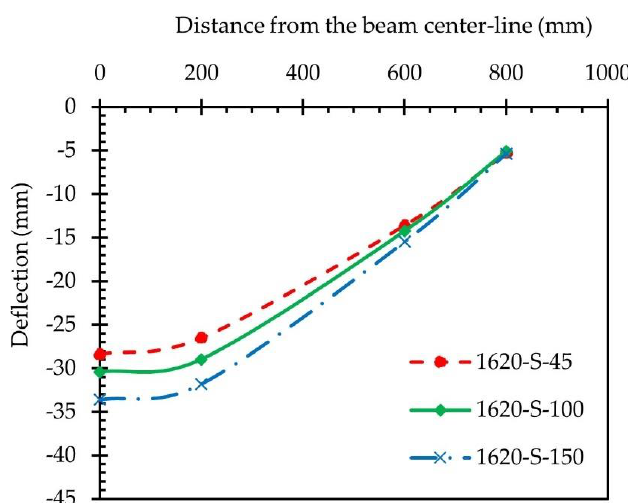
Figure 11. Load – deflection curves of 1620-S-45, 1620-S-100, 1620-S-150 and CB. Figure 11. Load–deflection curves of 1620-S-45, 1620-S-100, 1620-S-150 and CB.